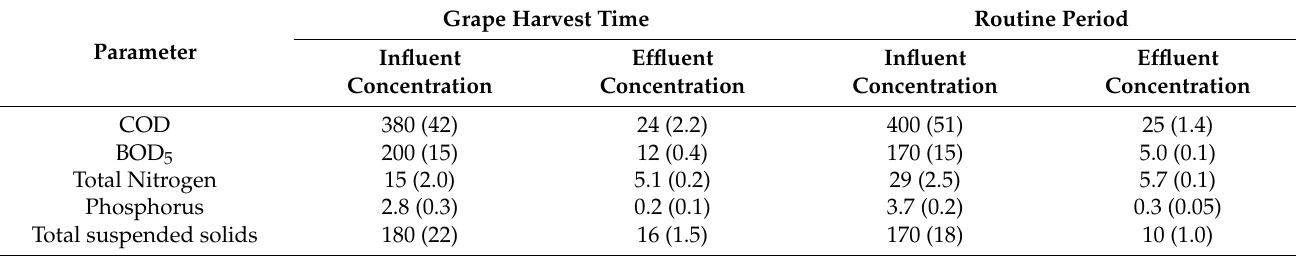
Table 8. Main influent and effluent wastewater characteristics measured during both monitoring campaigns (average values and standard deviation, between brackets, in mg/L).